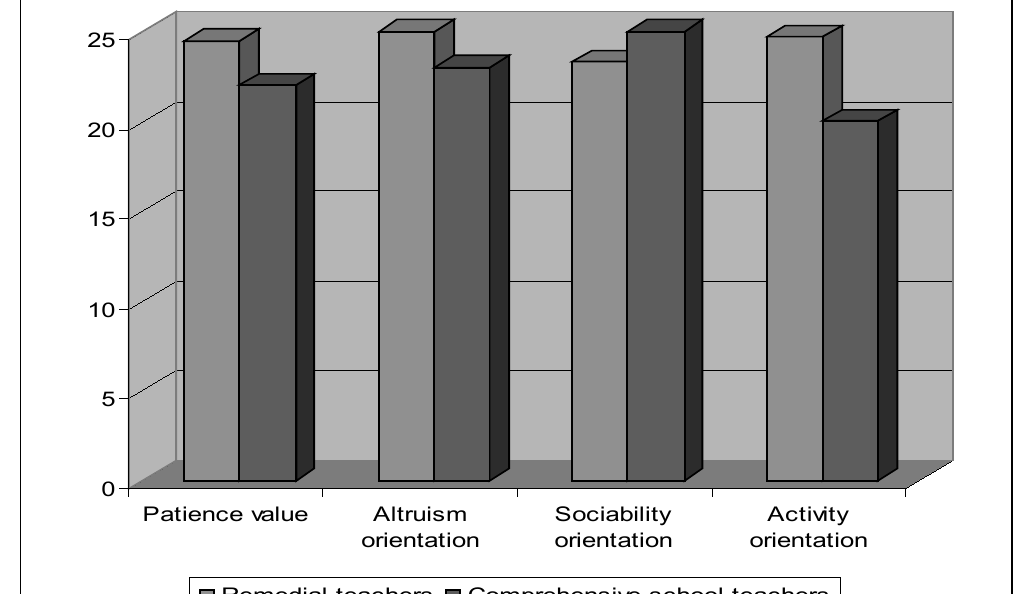
Fig. 1.3. The characteristics of comparative analysis by patience value, altru- ism, sociability and activity